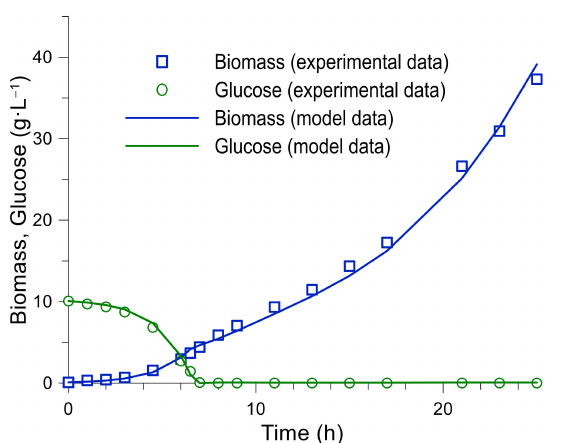
Figure 8. K. marxianus fourth bioreactor fed-batch cultivation. Process modelling results. Table 4. Parameters of Equations (6–7) determined from the fourth K. marxianus bioreactor cultivation.